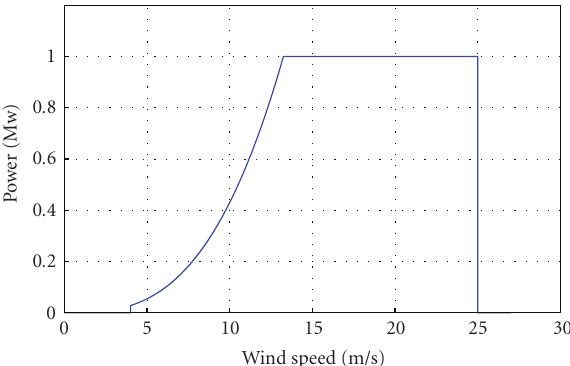
Figure 3: Power-wind speed